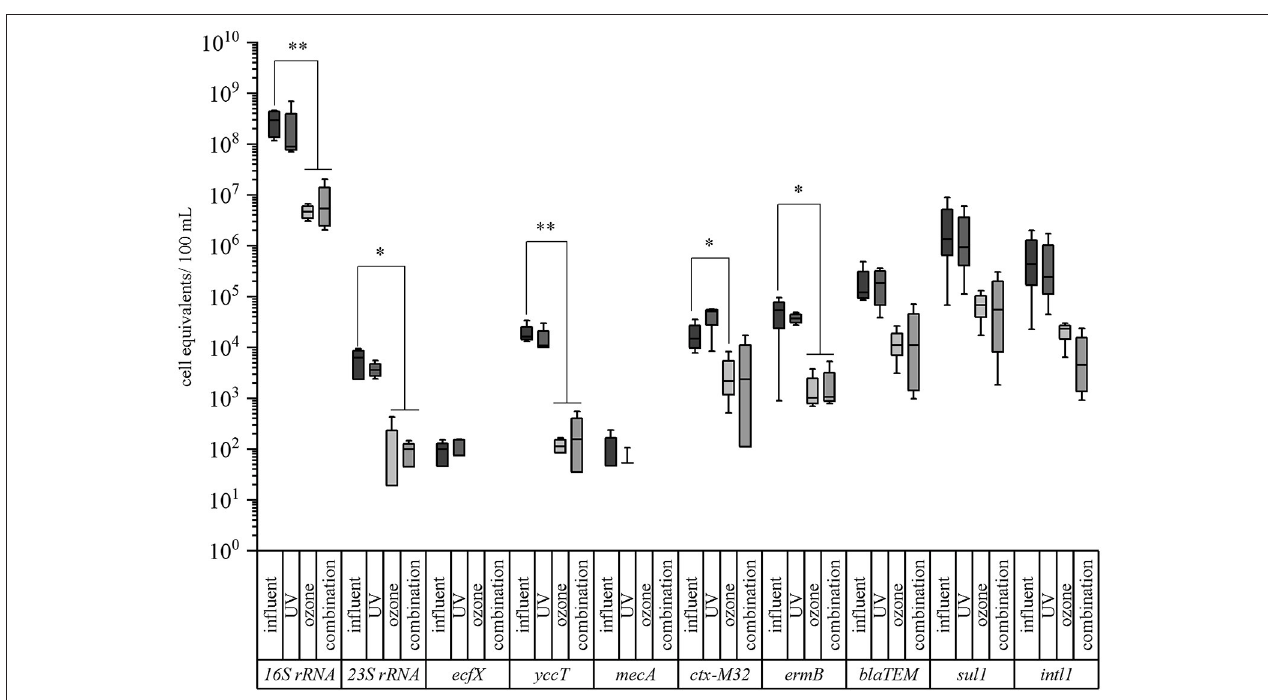
FIGURE 3 | Box plot graphs of the qPCR analyses targeting taxonomic and antibiotic resistance gene markers in advanced treated wastewater samples of a municipal WWTP. Data are given for the conventional treatment (activated sludge with sedimentation, influent), UV treated samples (400 J/m ² ), ozone treated